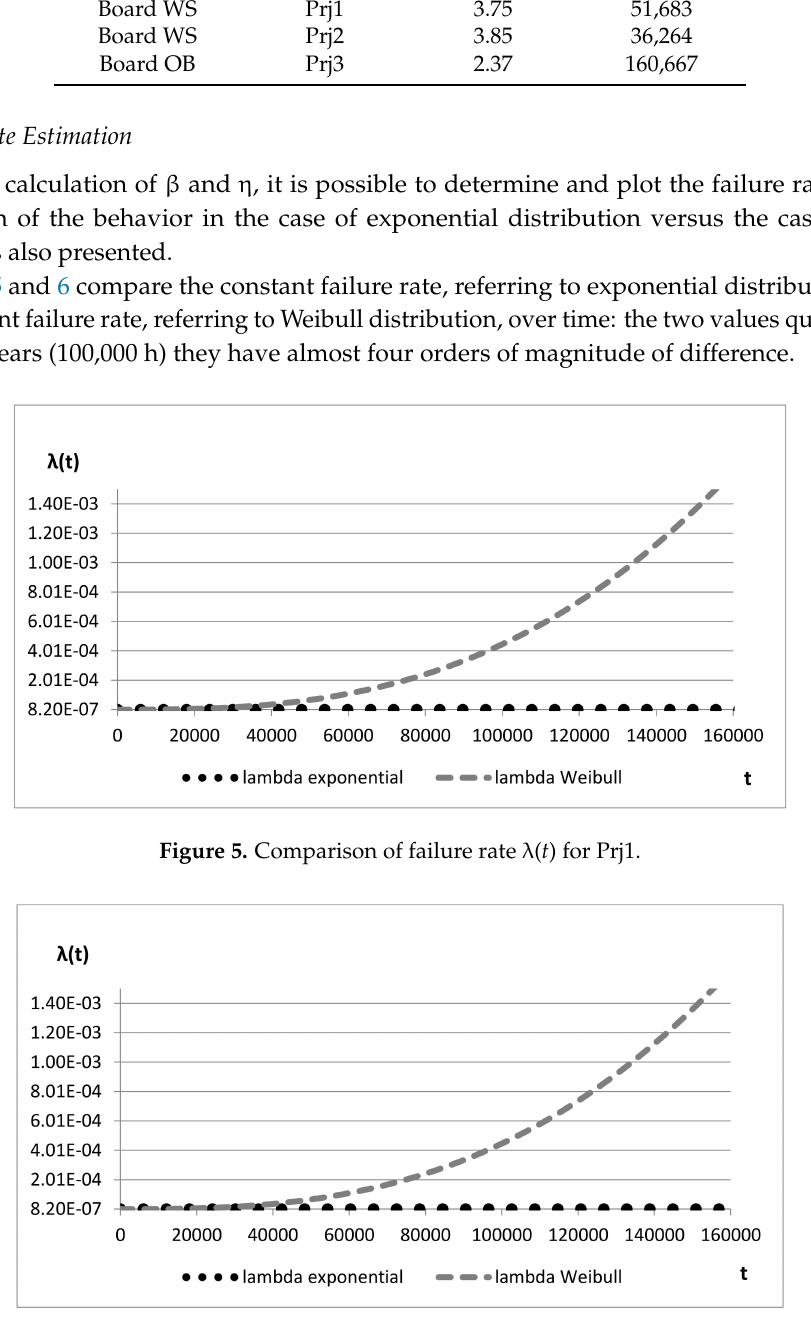
Figure 6. Comparison of failure rate λ ( t ) for